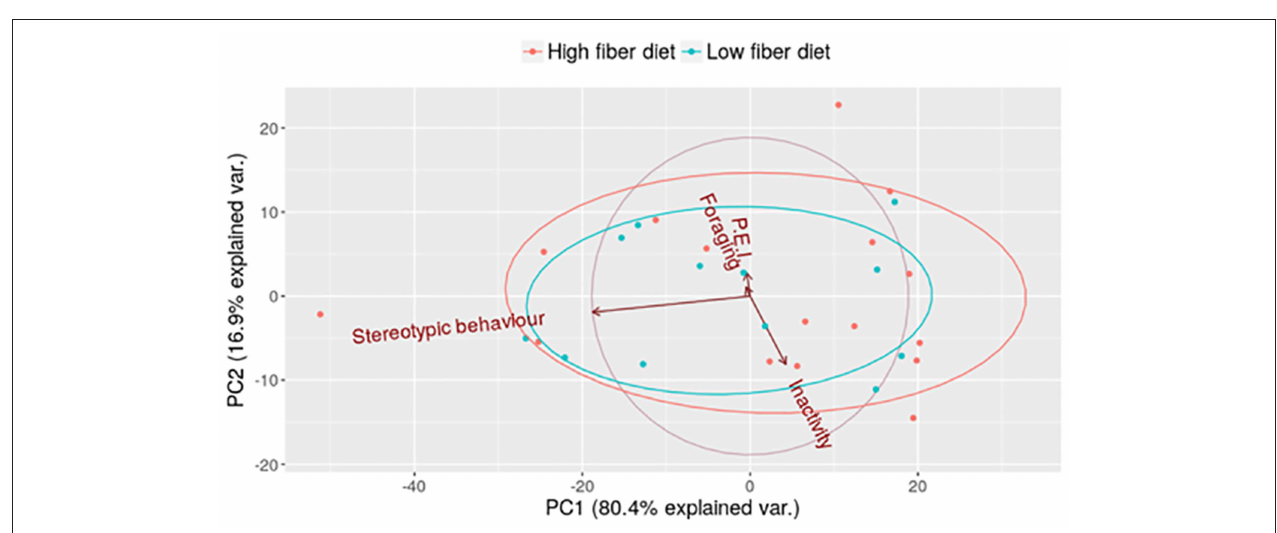
FIGURE 1 | Principal component analysis. PCA evaluated in relation to behavioral categories ( N = 28 pregnant sows group-housed; P.E.I. corresponds to physical environmental interaction).